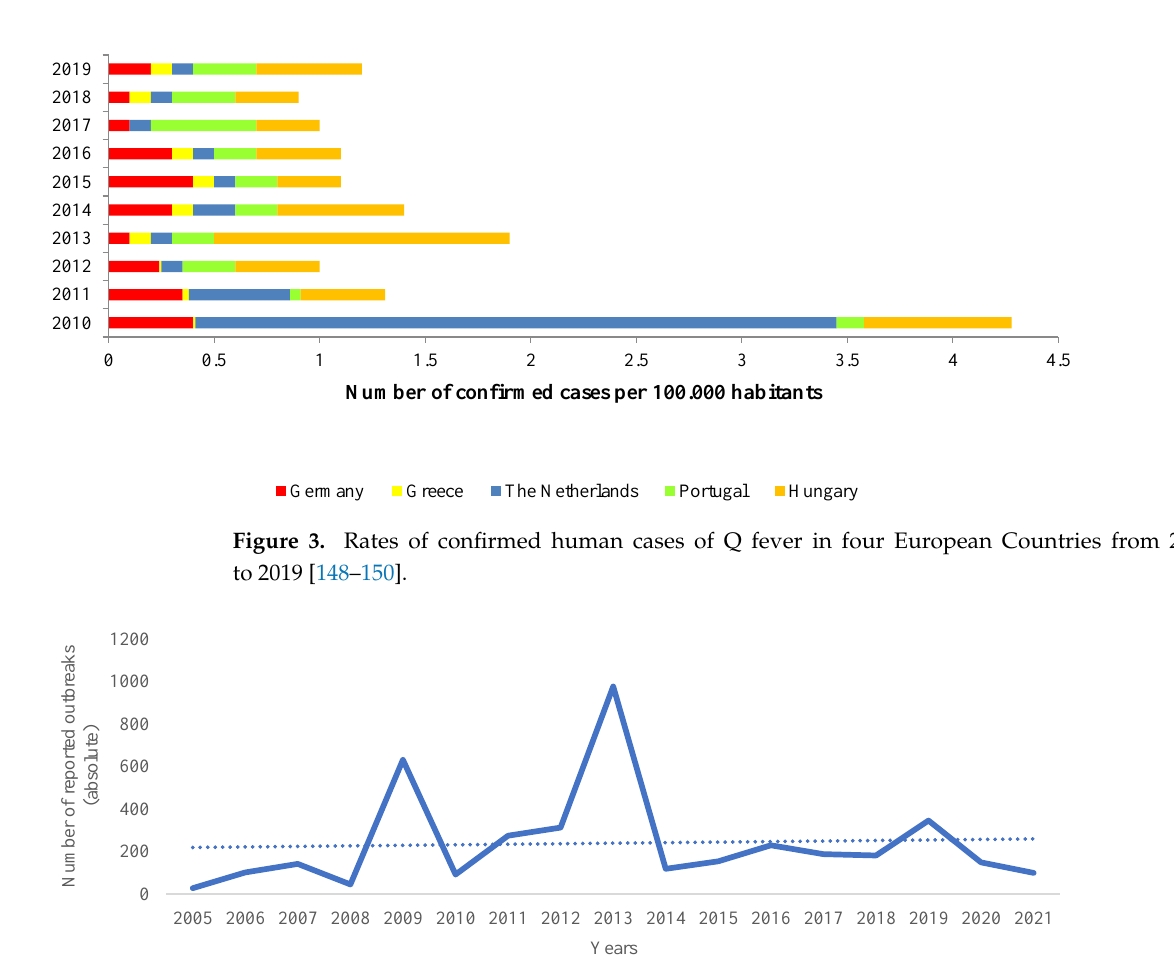
Figure 4. Number of Q fever outbreaks in goats reported in European countries from 2005 to 2021 and linear trend line [8].